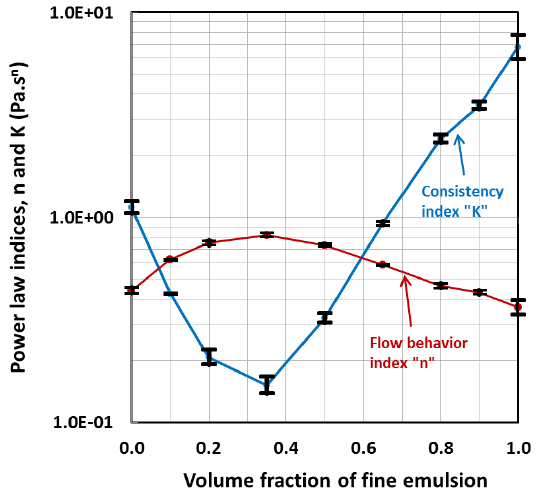
Figure 5. Power law parameters ( K and n ) with error bars for mixtures of fine and coarse O/W emulsions.